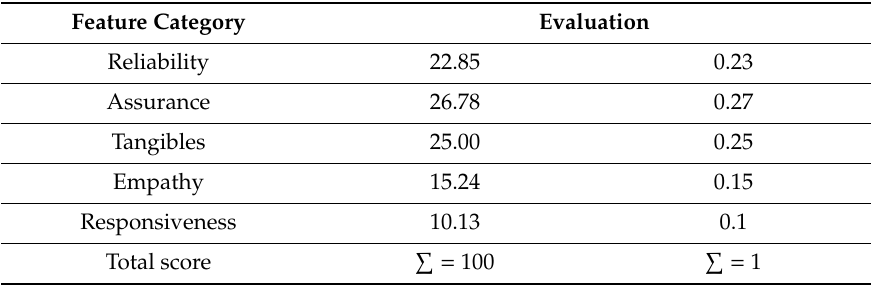
Table 3. Validation assessment of five dimensions for the Servqual